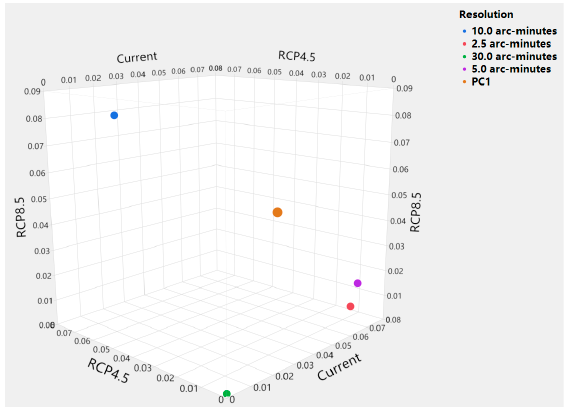
Figure 4. The linear relationships (coefficient of determination; R 2 ) between the invasion potential of IAPS and the invasion inequality of IAPS for protected areas across all the scales and PC1. Current: the present day; RCP4.5: low-gas-concentration scenario; RCP8.5: high-gas-concentration scenario.